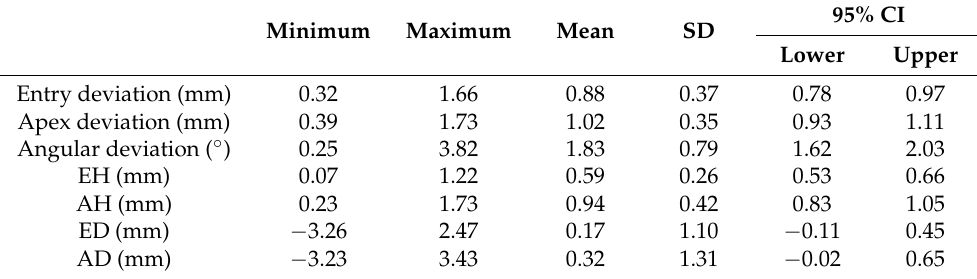
Table 1. Measurements of deviation between the DNS-based evaluation method and postoperative cone beam computed tomography